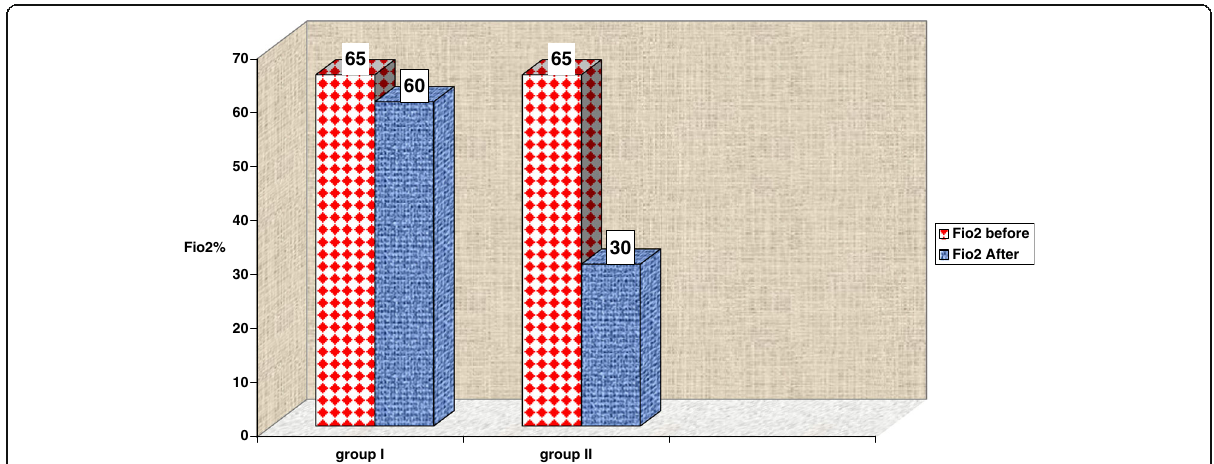
Fig. 2 FiO 2 % before and after treatment